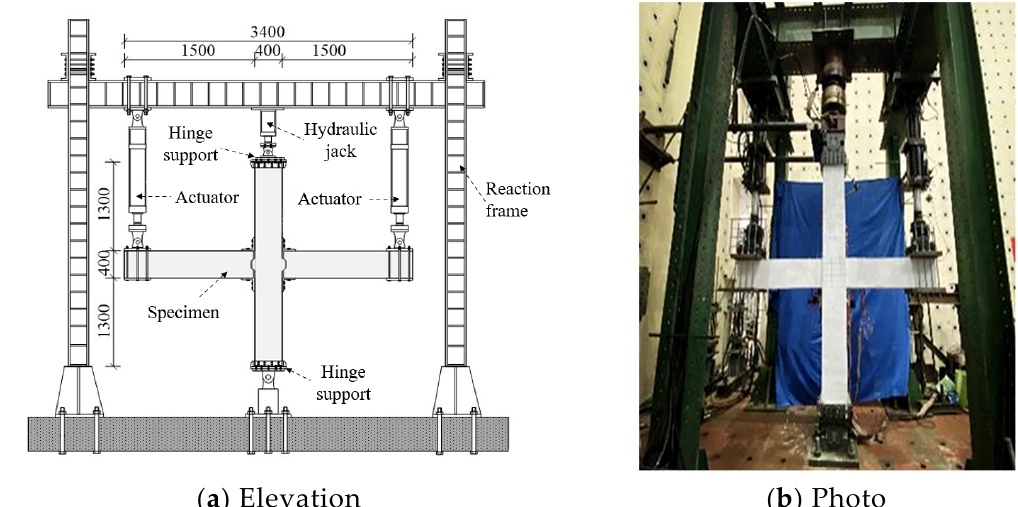
Figure 4. Test setup shown as a ( a ) diagram and ( b ) photograph. The applied loads were measured with load cells placed between the column top and the hydraulic ram. The load and displacement of the beam ends were measured by load cells and displacement transducers, respectively. Strain gauges were attached to the longitudinal steel bars and stirrups in the joint region to monitor strain change during the test.